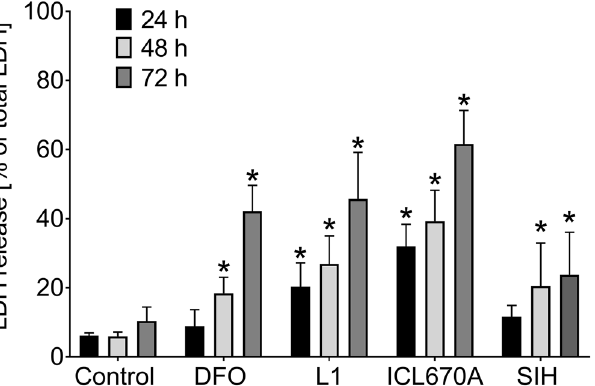
Figure 4. Comparison of own cytotoxic effect of Fe chelators DFO, ICL670A, L1 and SIH (all 100 µM) in differentiated PC12 cells. Cellular toxicities were determined after 24 h, 48 h or 72 h incubation using LDH activity assay and expressed as a percentage of the LDH released from completely lysed control cells. Data are presented as means ± SD ; n ≥ 4; Statistical significance (ANOVA, p ≤ 0.05): * vs. control